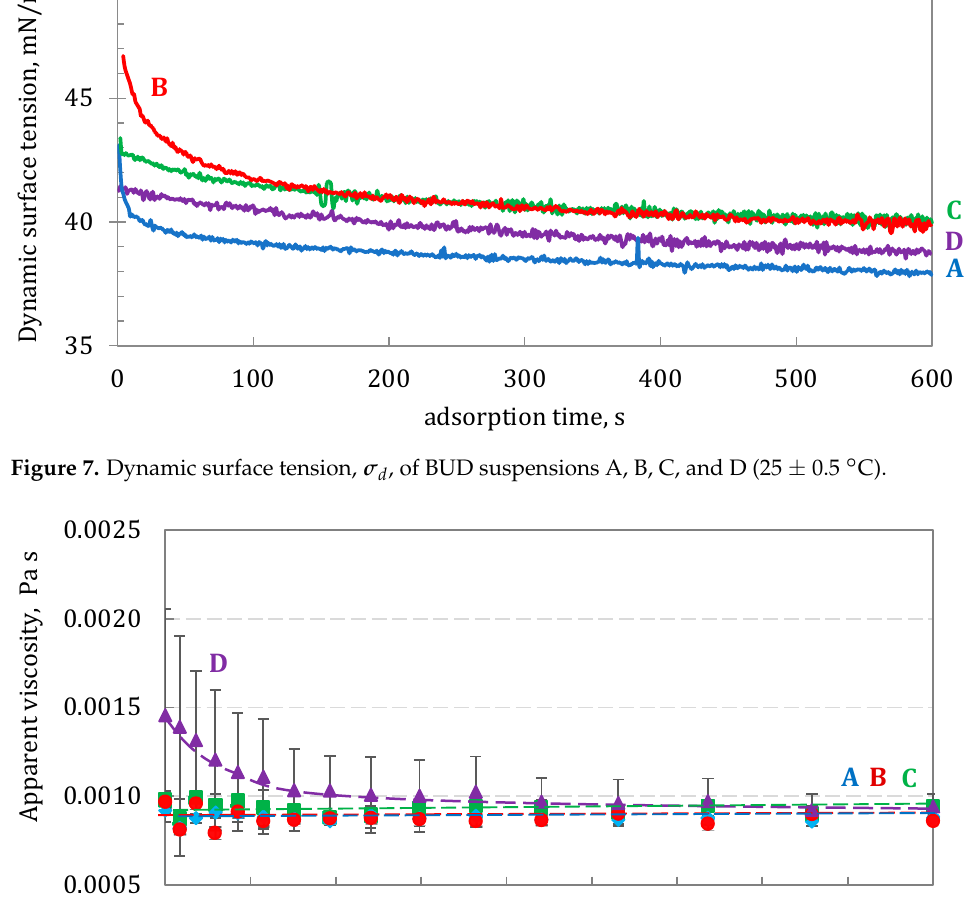
Pharmaceutics 2023 , 15 , x FOR PEER REVIEW 10 of 18